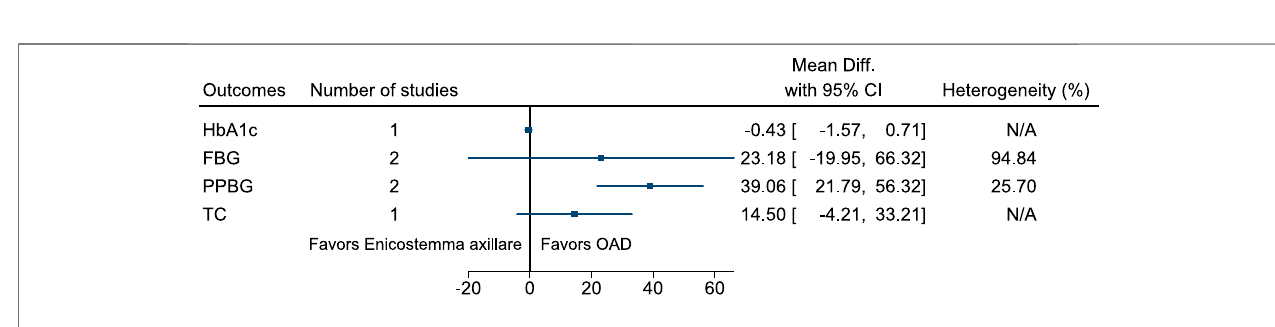
FIGURE 18 | Enicostemma axillare (versus OAD) — Summary forest plot.